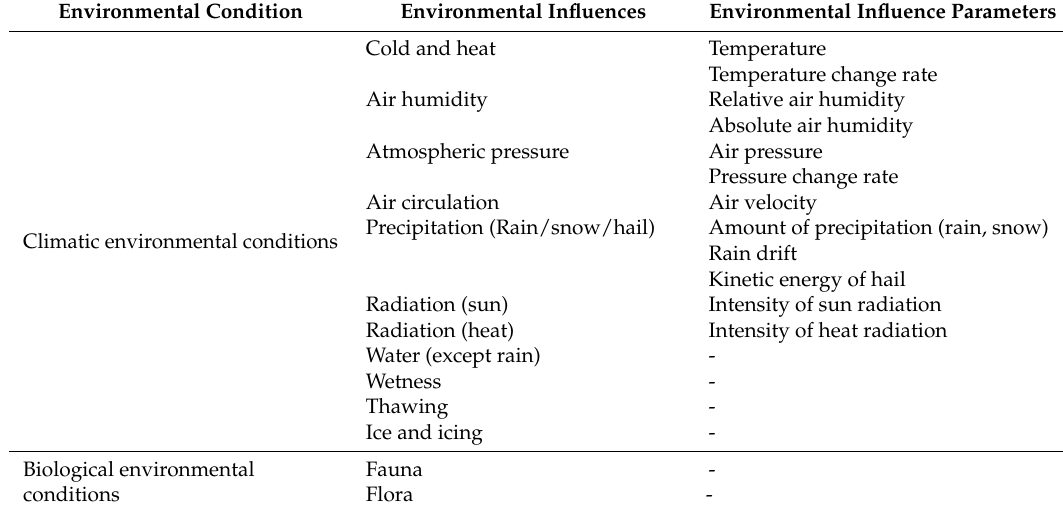
Environmental conditions, environmental influences and environmental influence parameters that are relevant to transport processes, according to standards DIN EN 60721-1:1997-02 and DIN EN 60721-3-2:2016-06